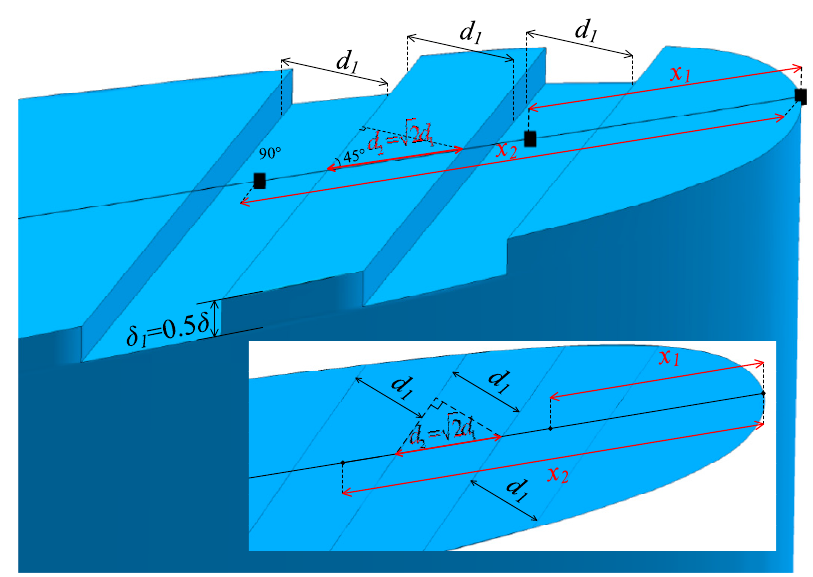
Figure 2. Structure parameter illustration of parallel groove.